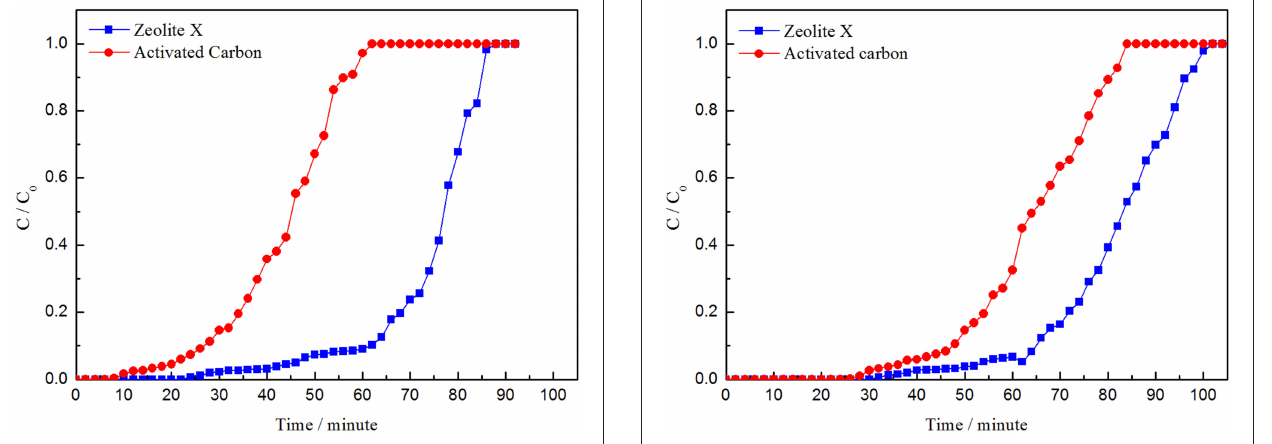
FIGURE 8 | Adsorption curves of cyclohexane by zeolite X and activated carbon.